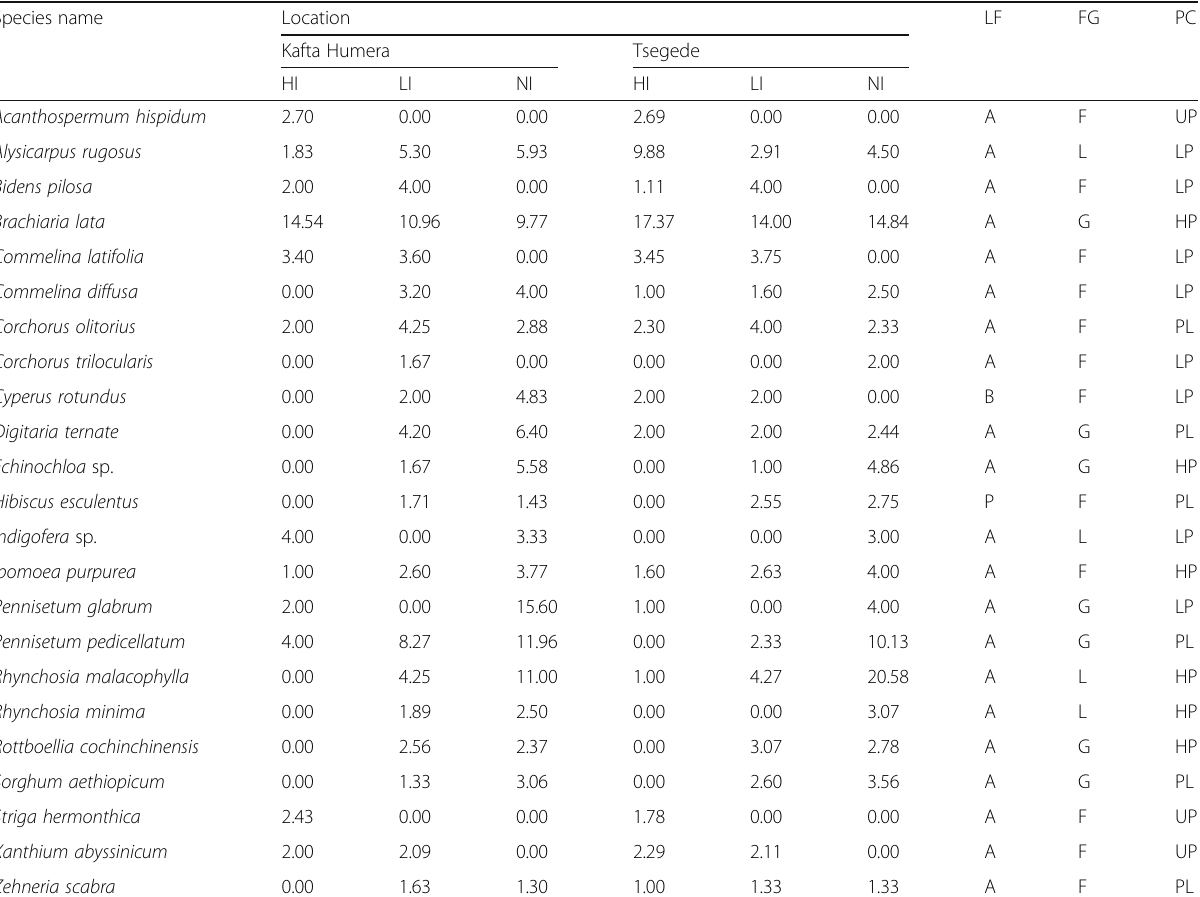
Table 1 List of herbaceous species with their absolute abundance (number of plants in m − 2 ), life forms (LF), functional groups (FG), and palatability category (PC) under three invasion levels of Senna obtusifolia (L.) (NI non-invaded; LI lightly invaded, HI heavily invaded) at two locations, northern